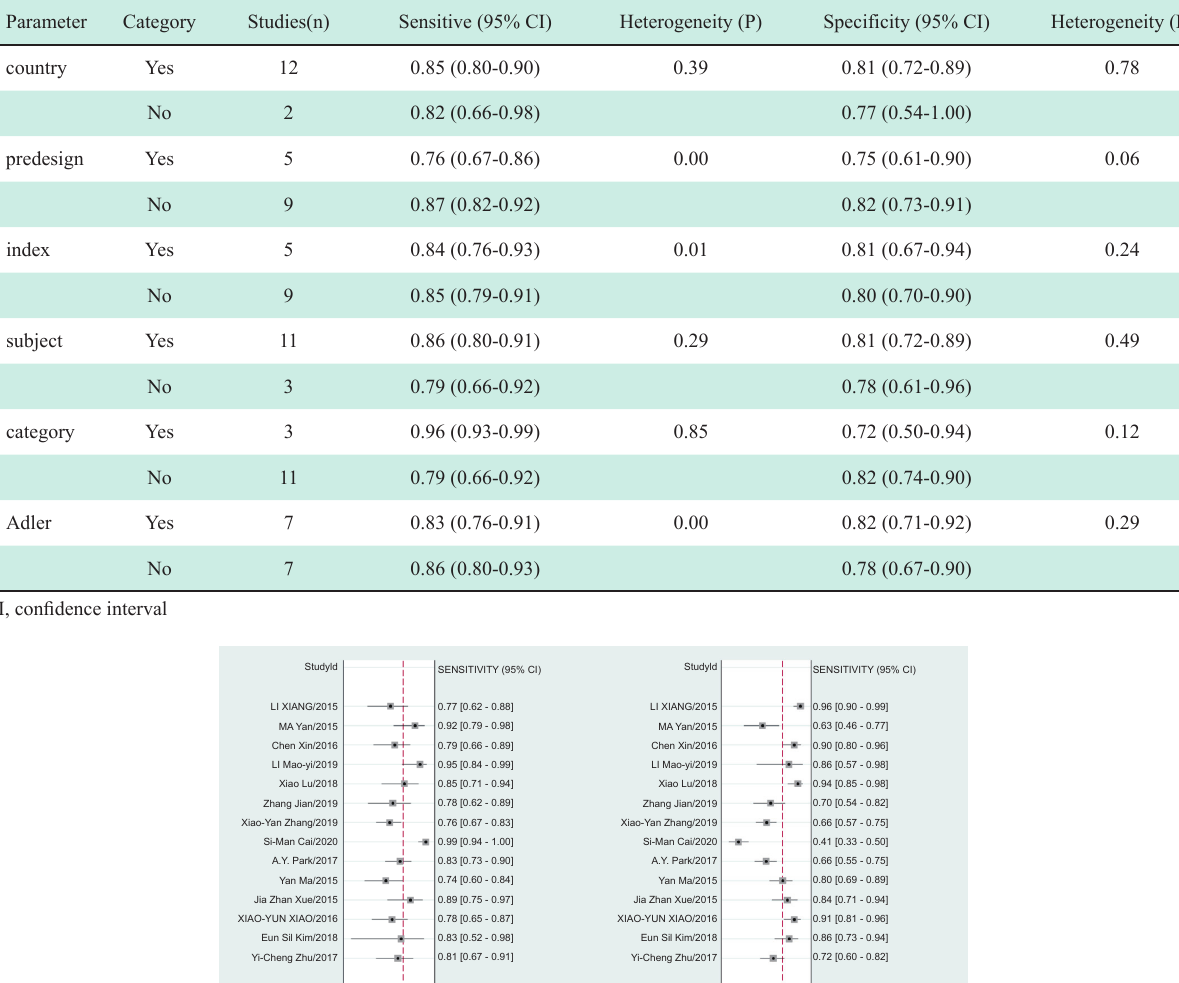
Table 3 Sensitivity, specificity, and AUC for each subgroup